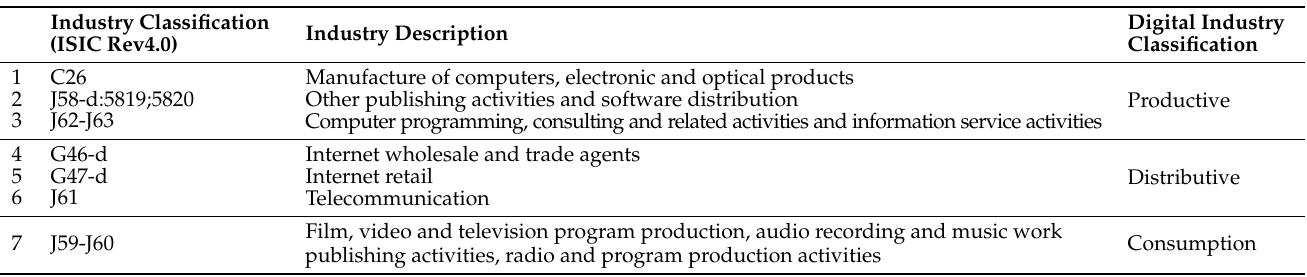
Table 1. Classifications of digital